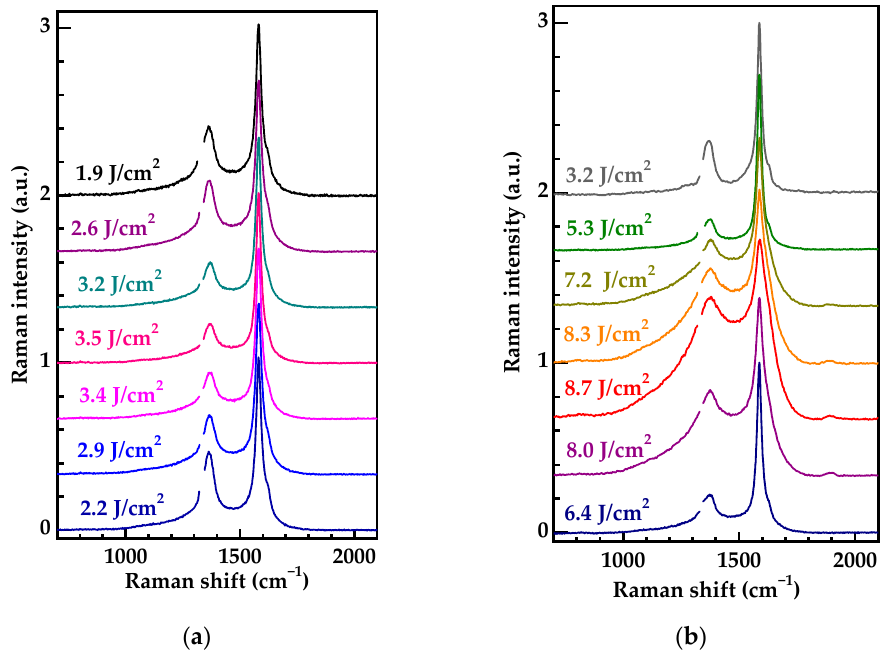
Figure 5. Raman spectra of graphitized structures: obtained at a laser pulse energy of 0.46 μ J ( a ) and 1.11 μ J ( b ). The spectra are normalized to the amplitude of G-band and shifted for clarity. The trend of change in the structural perfection of the graphitized phase in the 1.11 The corresponding change in the ratio of the intensities of the D and G-bands (I D /I G